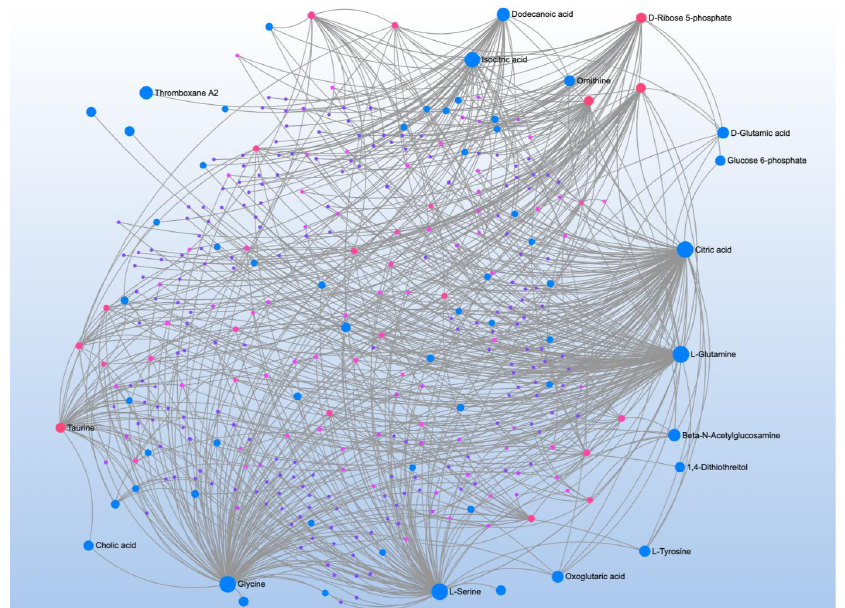
Figure 4. Metabolite-metabolite interaction network for significant metabolites that correlate to neurodevelopment. Size of the node indicates importance in the network. The interaction analysis highlights with citric acid cycle intermediates, citric acid and isocitric acid, as well as glucogenic amino acids, such as L-serine, glycine, and L-glutamine, highlighting the role of energy metabolism and the mitochondria specifically. The SRS correlated with 30 metabolites that mapped to 7 significant pathways (Table 7). Metabolite-metabolite interaction analysis confirmed the central role of D-ribose 5-phosphate and highlighted the metabolic and signaling roles of various CAC metabolites, such as citrate and isocitrate (Figure 5). This analysis also underlined the major role of the neurotransmitter, glycine; the glucogenic amino acids, L-alanine, L-glutamine, and L-ser- ine; and the ketoacids, alpha-ketoisovaleric acid and phenylpyruvate. These metabolites were matched to various significant pathways such as glyoxylate and dicarboxylate me- tabolism; aminoacyl-tRNA biosynthesis; alanine, aspartate and glutamate metabolism; and glycine, serine and threonine metabolism.